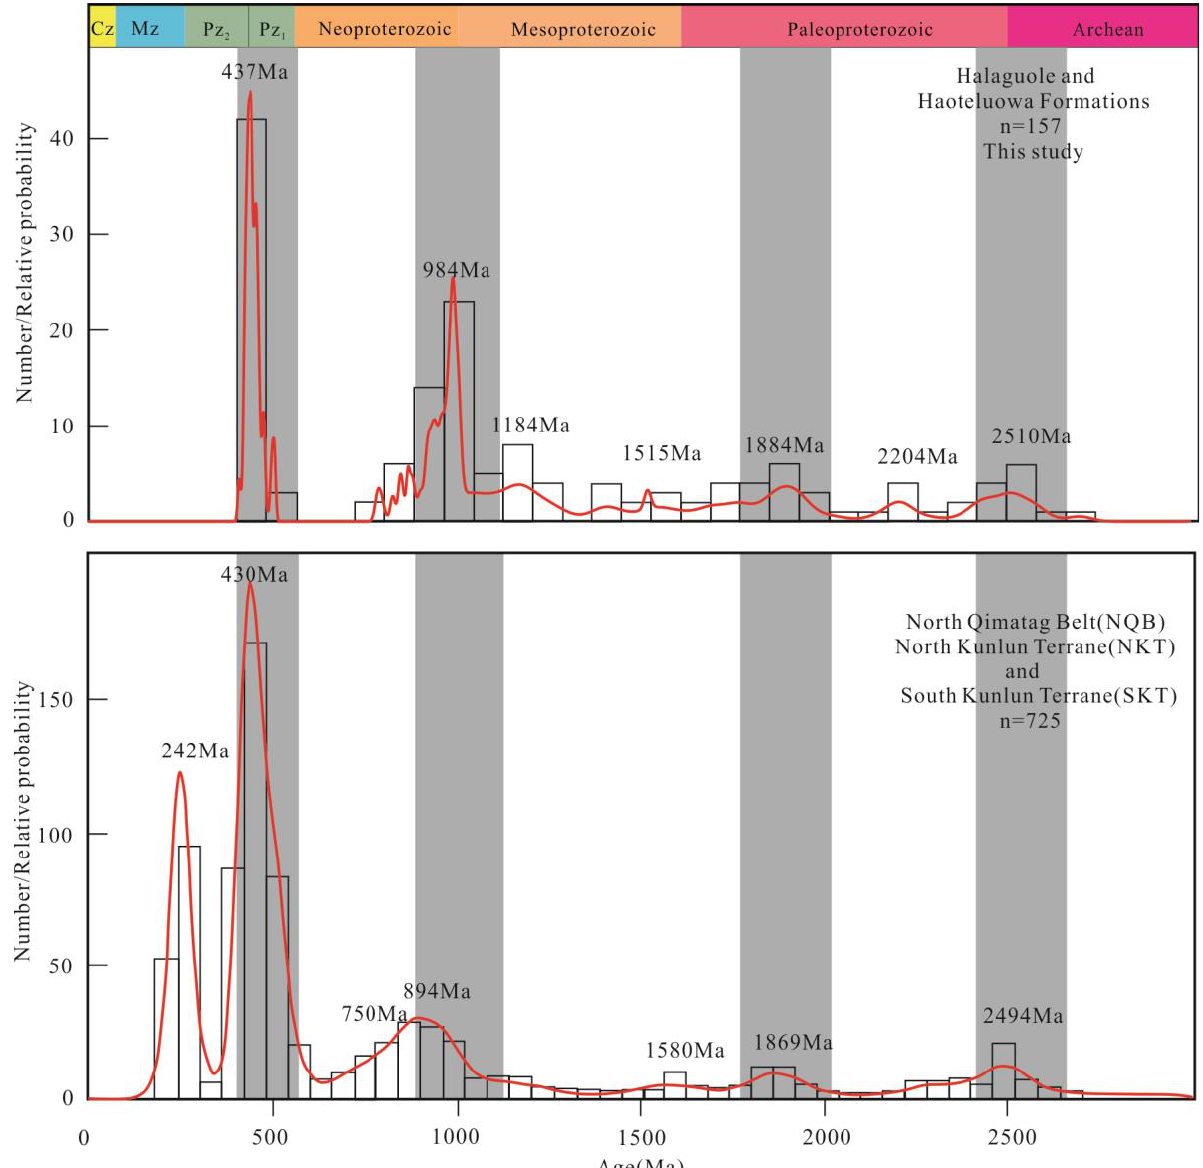
Figure 9. Comparison of detrital zircon ages from the sedimentary rocks in this study and those from the counterparts in the East Kunlun Orogen [68]. The gray boxes represent the areas where the age peaks of zircons for clastic rocks of East Kunlun Orogen.